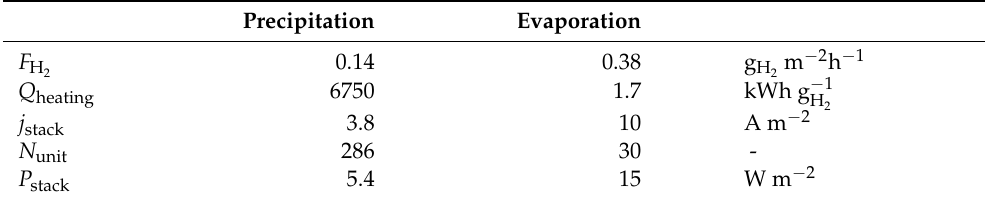
Table 2. H 2 production rate, total heating/cooling duties, current density, number of unit cells, and stack power calculated for the evaporation case and the precipitation case